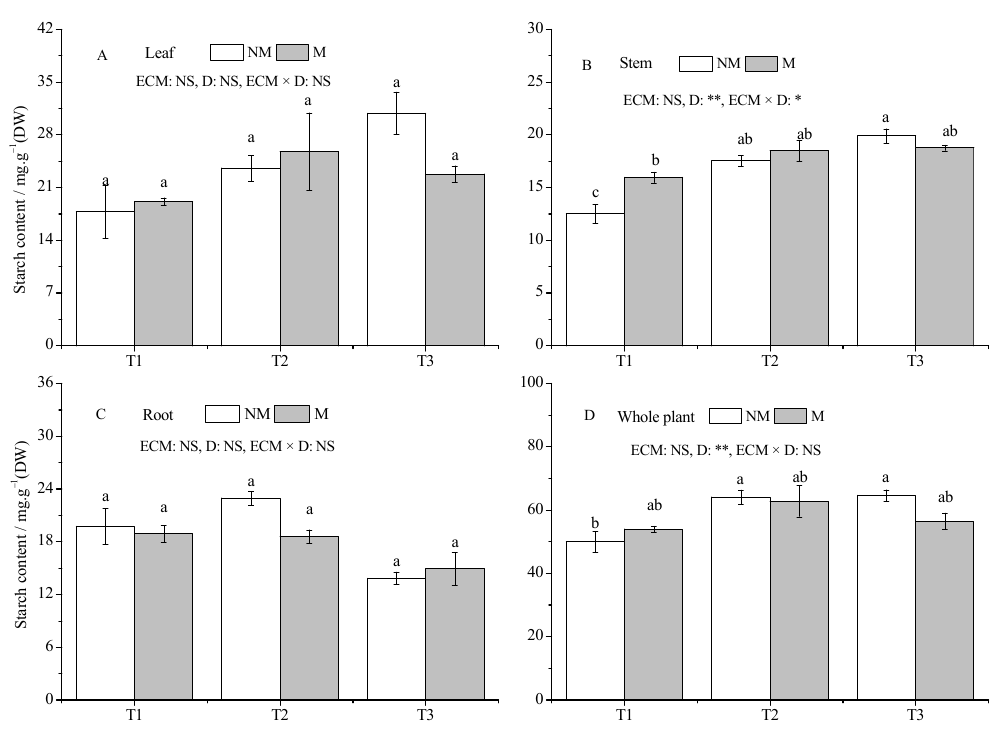
Figure 5. Effect of ECMF and drought on the starch contents of various tissues and whole plants of P. massoniana. Values (means ± SEs) followed by different letters among treatments indicate significant differences at the 5% level, and the same letter indicates no significant difference. NS, not significant, * p < 0.05; ** p < 0.01. T1, well-watered, T2, moderate drought, and T3, severe drought. NM, no Sl inoculation, M, Sl inoculation. D, drought treatment. The letters denote ( A ) leaf starch; ( B ) stem starch; ( C ) root starch; ( D ) whole plant starch.